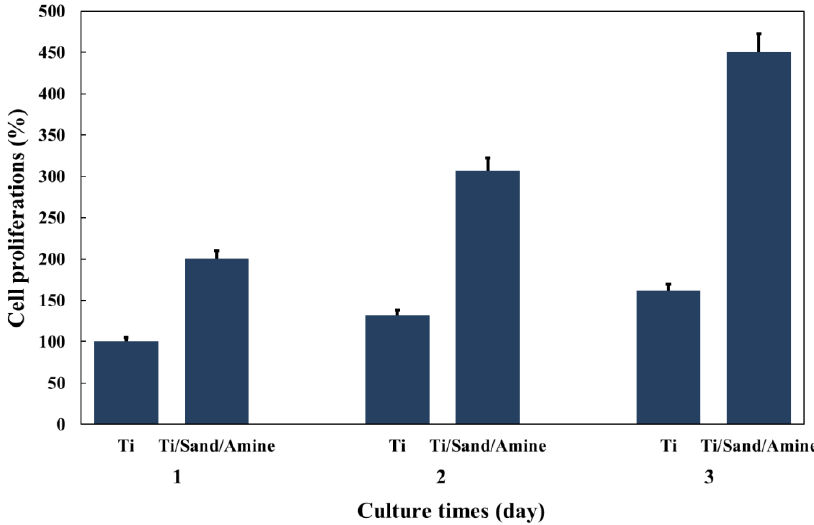
Figure 7. Untreated titanium surface and titanium surfaces treated with amine plasma. Proliferation rates of cultured osteoblasts on the surfaces after one, three, and five days.